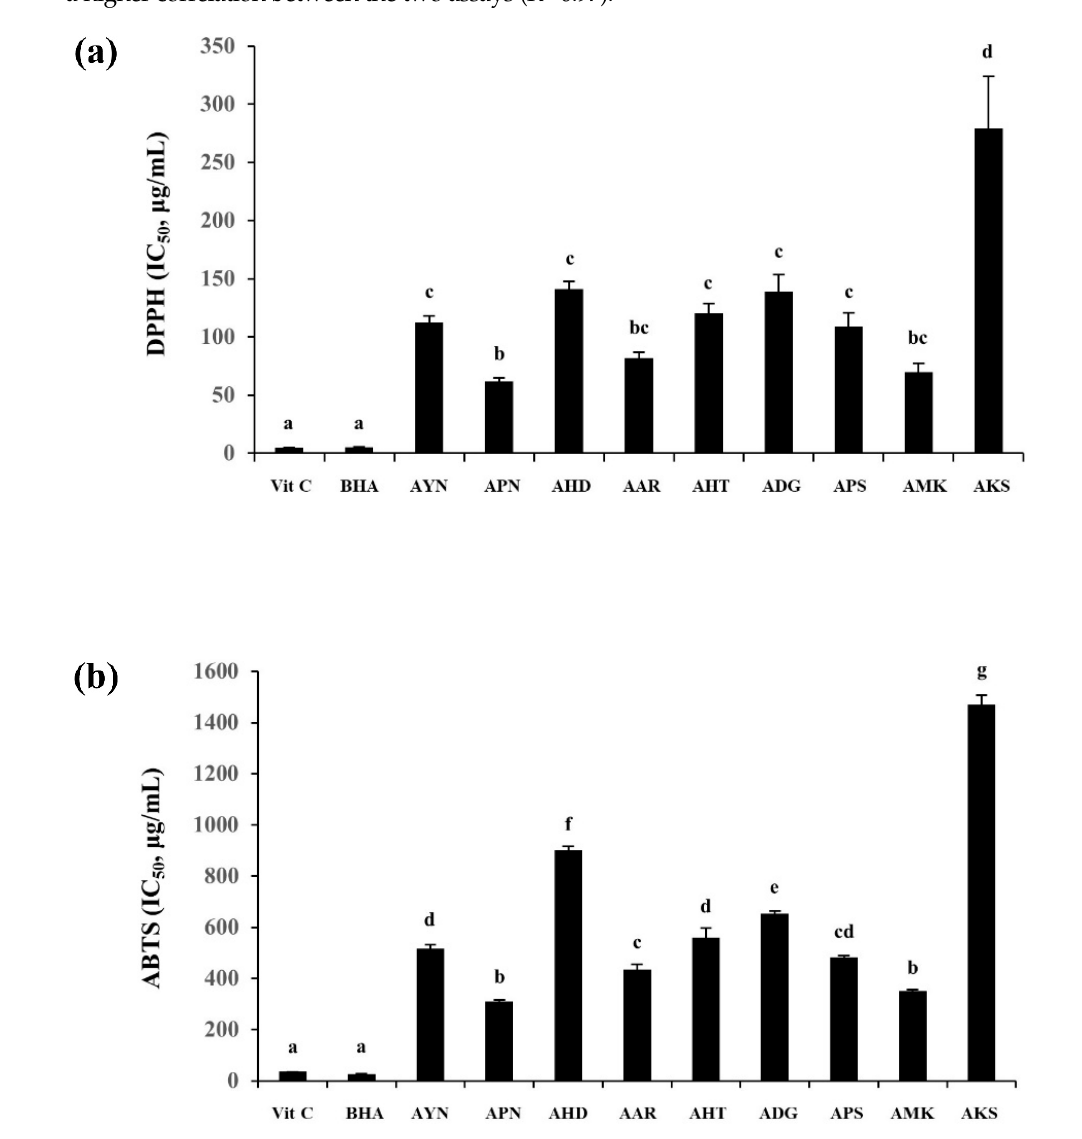
Figure 8. DPPH ( a ) and ABTS ( b ) radical scavenging capacity of the flowers of Aster species. Different letters in columns indicate significance from Tukey post hoc test (A value of p < 0.05 was considered significant). Error bars indicate standard error of the mean.